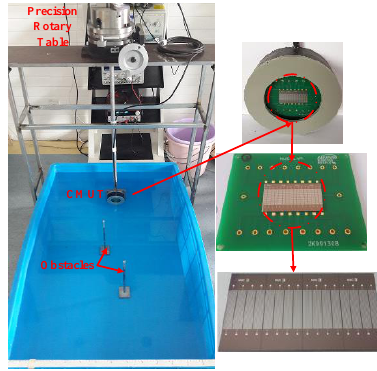
Figure 6. Sector scanning configuration.